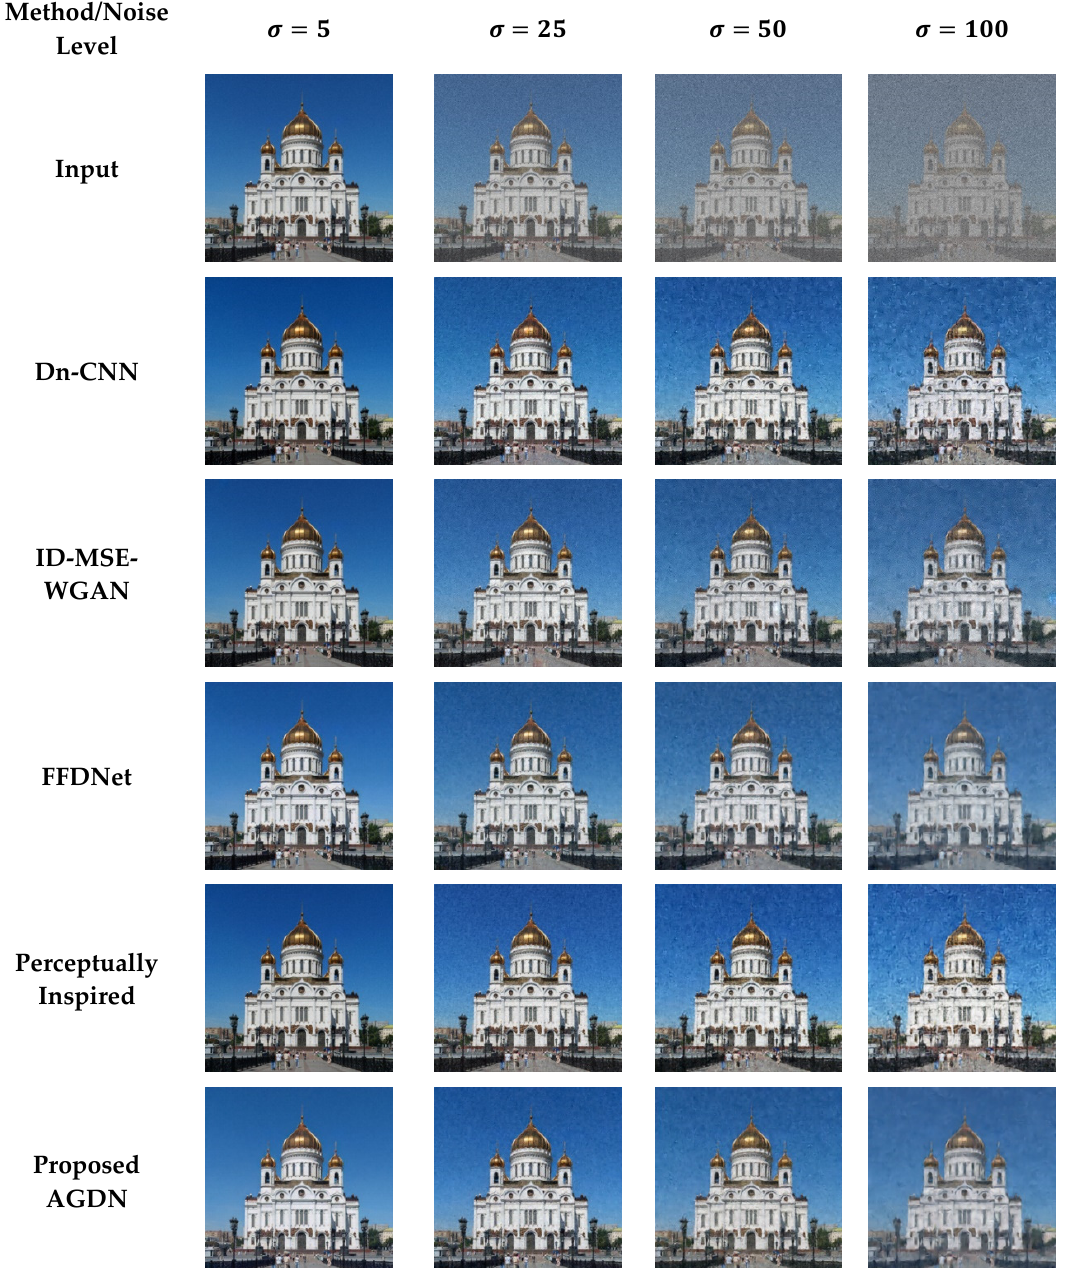
Figure 11. First example results of image denoising tasks on the DIV2K dataset. The first to last column images generated by the noise level of sigma 5, 25, 50, and 100, respectively. First-row shows input images, second-row to the last row presents the results of Dn-CNN, ID-MSE-WGAN, FFDNet, the perceptually inspired method, and the proposed AGDN, respectively.